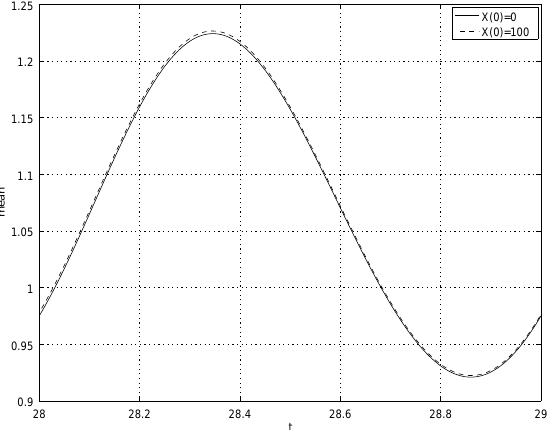
Figure 2. The mean E ( t ,0 ) and E ( t ,100 ) for t ∈ [ 28,29 ] , this figure shows approximation of the limiting mean.